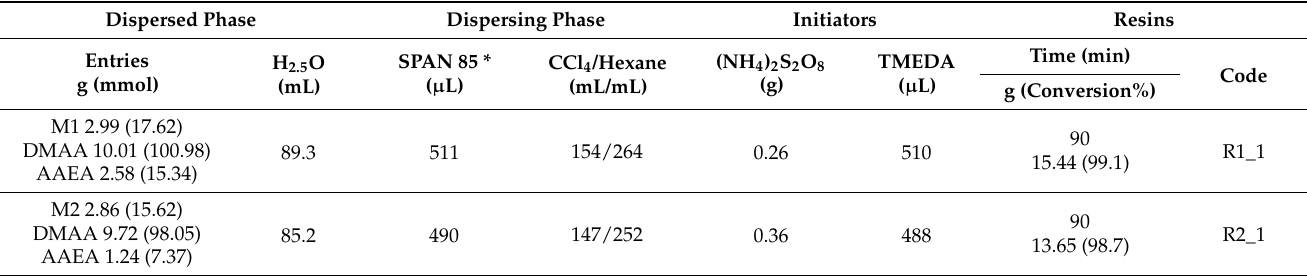
Table 8. Experimental data of optimized polymerizations which provided high quality R1 and